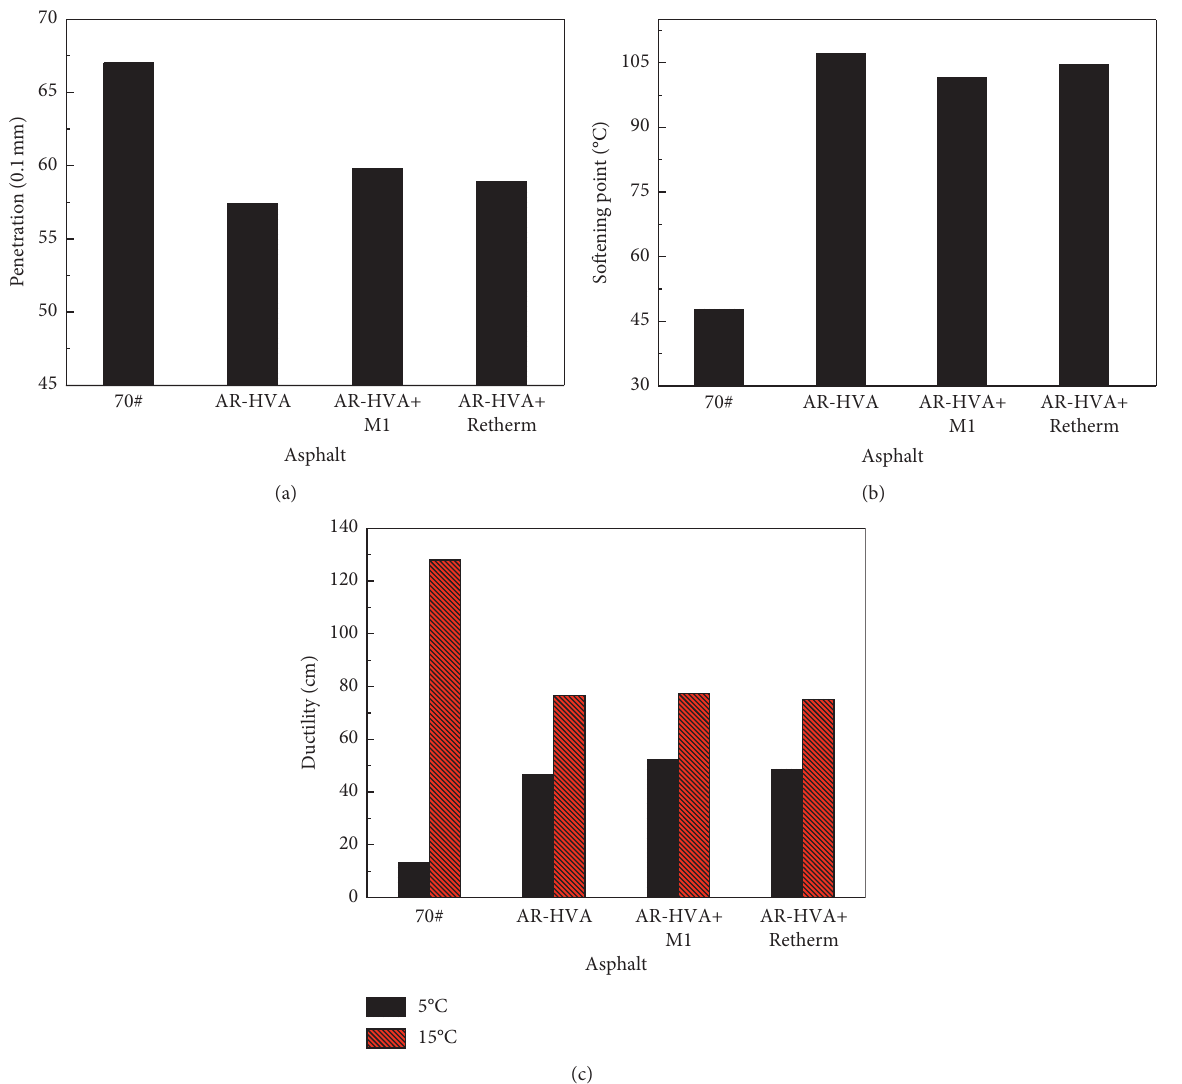
Figure 3: Penetration, softening point, and ductility test results of different asphalts. (a) Penetration. (b) Softening point. (c)